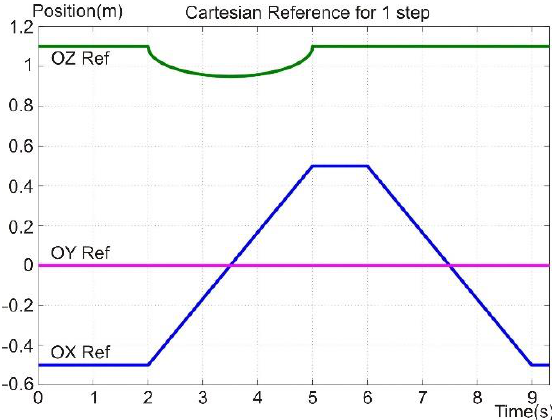
Figure 10. MATLAB Simulink diagram for the hybrid control.